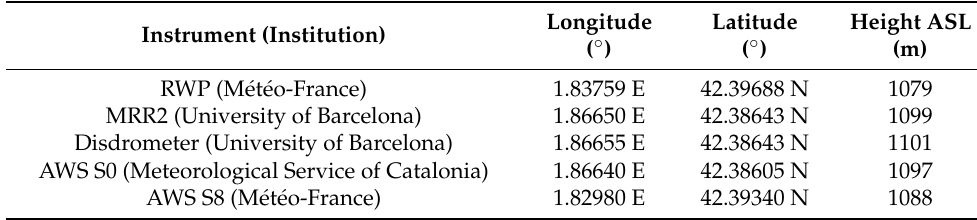
Table 1. Location of instruments